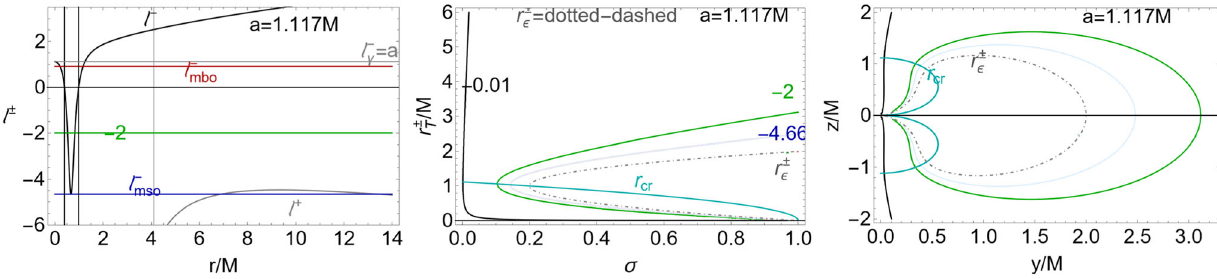
Fig. 14 Double co-rotating tori system with fluid specific angular momentum (cid:6) = (cid:6) − for a = 1 . 117 M . See Fig.